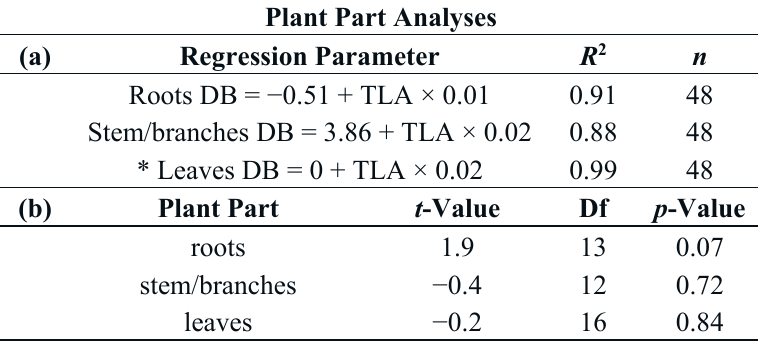
Table 1. ( a ) Regression parameters for dry biomass (DB in g) of each plant part (roots, stem/branches, leaves) against total leaf area (TLA) of each plant listed with the corresponding R 2 value and the sample size ( n ). The regression parameters were used to calculate the DB of each plant part for the first sampling referring to its TLA; ( b ) Results of t -tests ( t -value, df-Degree of freedom and p -value) for the growth increment of each plant part between treatments (burrow, control).